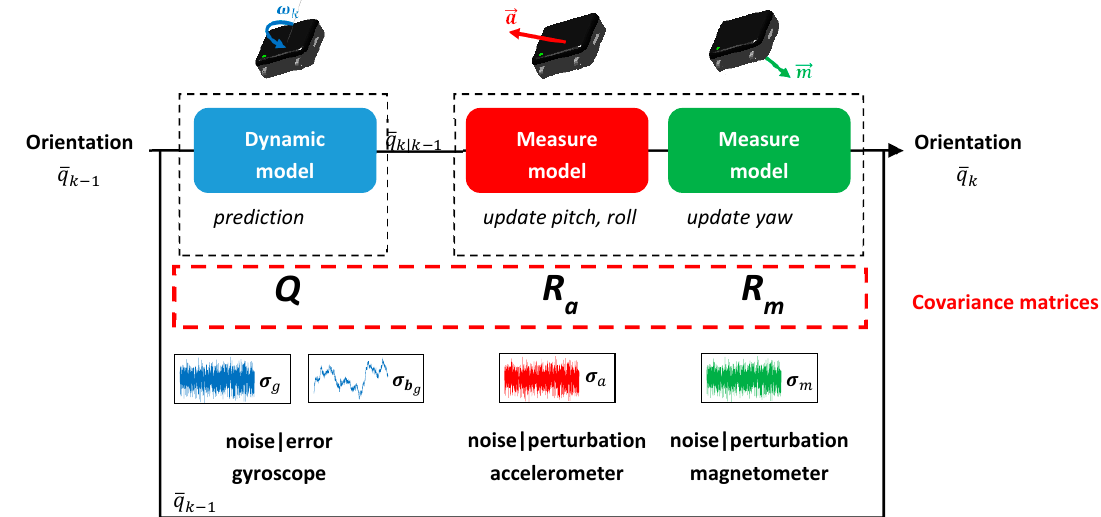
Figure 2. Schematic diagram of the custom Kalman filter.